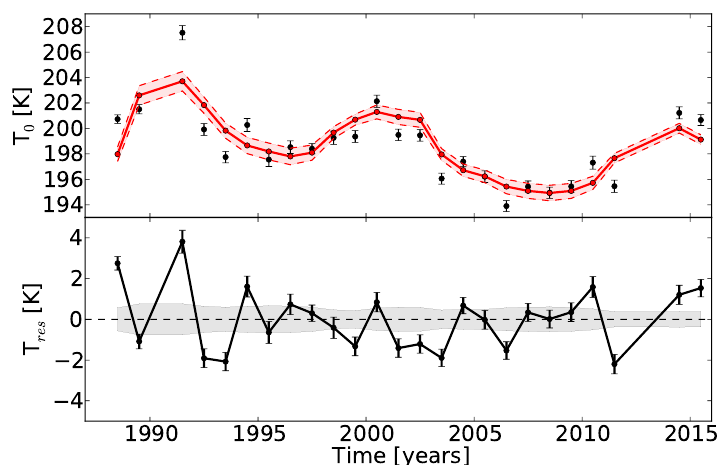
Figure 10. The upper panel of the figure shows the time series of annual average OH ∗ temperatures in black and the fit corresponding to Eq. (9) with the regression coefficients C hale = (1.8 ± 0.5)K ( 100µT ) − 1 and C solar = (5.0 ± 0.7)K ( 100SFU ) − 1 in red. In the lower panel the residual T res of the two is shown. For description of displayed uncertainties see Fig. 6.